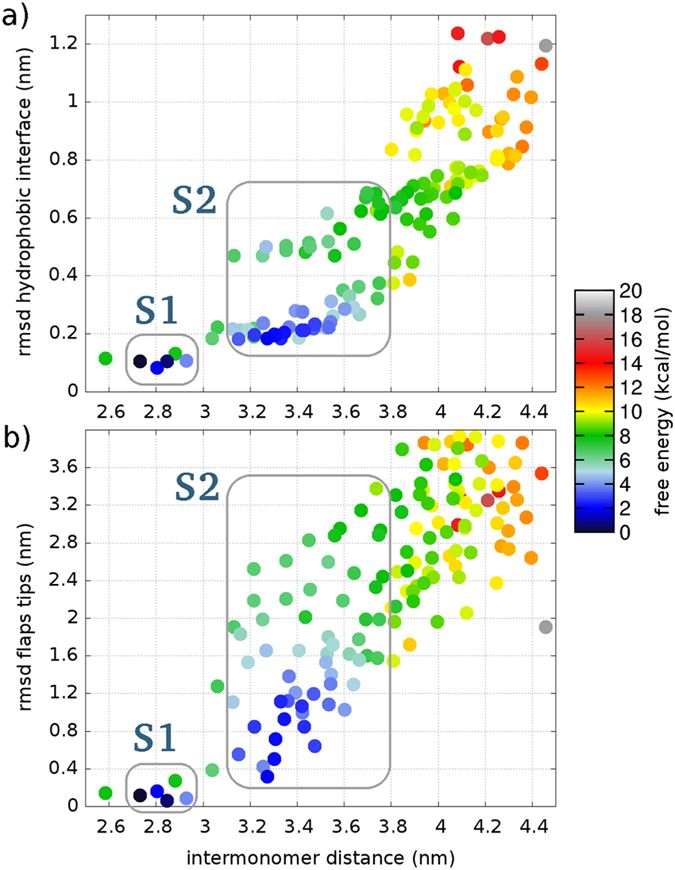
Free energy landscape as a function of different collective variables.The 150 structural clusters composing the ensemble of conformations are shown as colored dots.